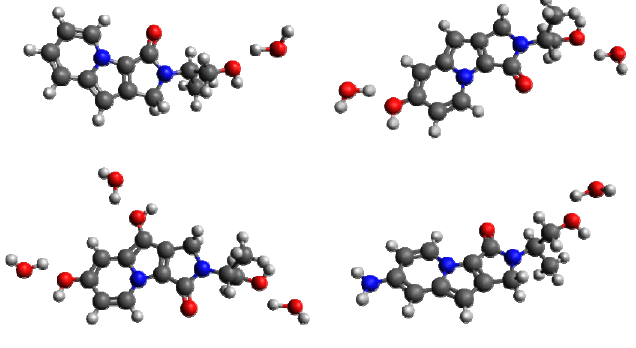
Figure 4. Molecules 2a – 2d clockwise from top-left, with added explicit water